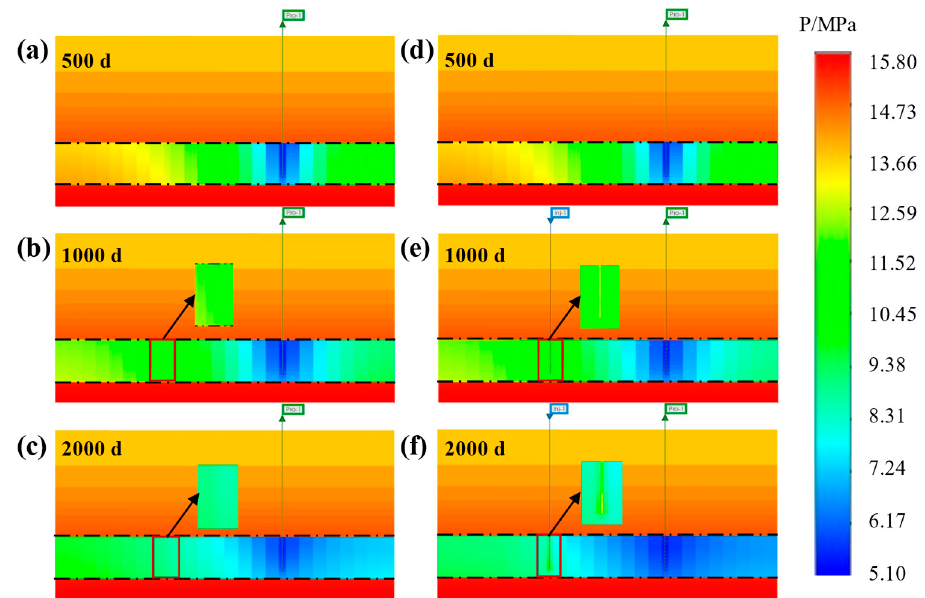
Figure 5. Evolution of P after 500 days, 1000 days, 2000 days (( a )–( c ) for Case A and ( d )–( f ) for Case B).